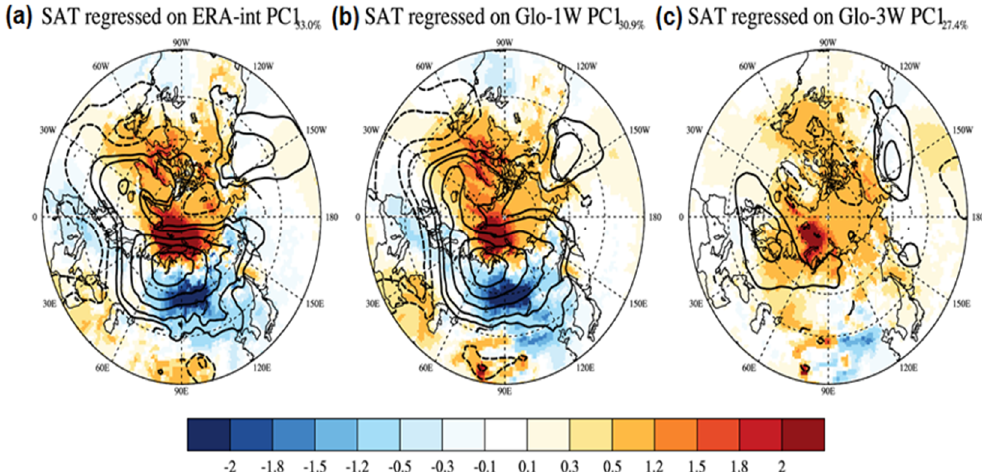
Figure 7. Surface temperature (shaded) and sea level pressure (contours) regressed onto the EOF 1st PC from ( a ) ERA−Interim, ( b ) GloSea5 with a lead time of l week, and ( c ) GloSea5 with a lead time of 3 weeks.